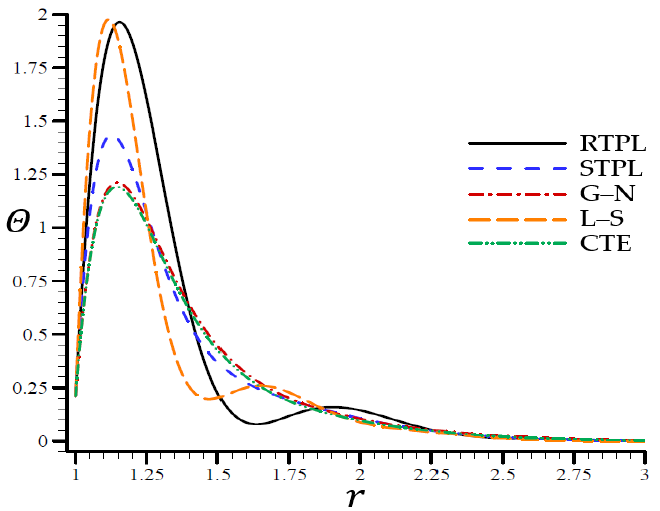
Figure 2. The temperature 𝛩 through the radial direction of the spherical hole for all models. Figure 2 depicts the temperature difference across the radial direction of a spherical hole matching all models. Figures 3–6 show comparable figures for the remaining variables. For the CTE, L–S, G–N, and STPL models in Figure 2, the temperature oscillated along the trajectory of the RTPL model. After r = 2.25, the temperature remained stable in all models, and the temperature values were near to one another.